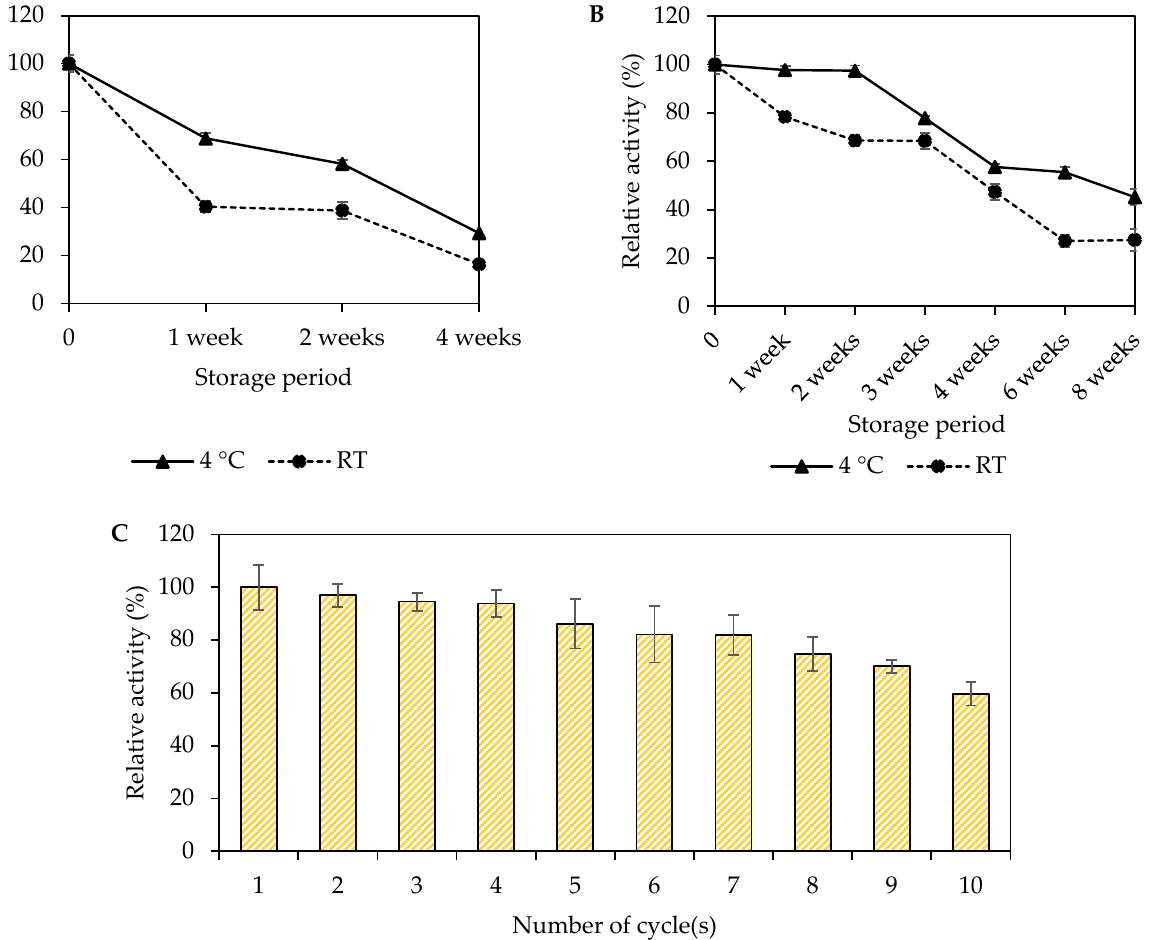
Figure 9. ( A , B ) Storage stabilities of free and immobilized Mycobacterium phlei carboxylic acid reductase ( Mp CAR) on Seplite LX120 with optimized immobilization conditions, and ( C ) reusability of immobilized Mp CAR. Both free ( A ) and immobilized ( B ) MpCAR were stored for a period of time at 4 and 25 °C (room temperature). The relative activity (%) at day 0 of storage was referred to as 100%. For ( C ), the initial activity of the immobilized Mp CAR was taken as 100%. Samples were measured in triplicates.